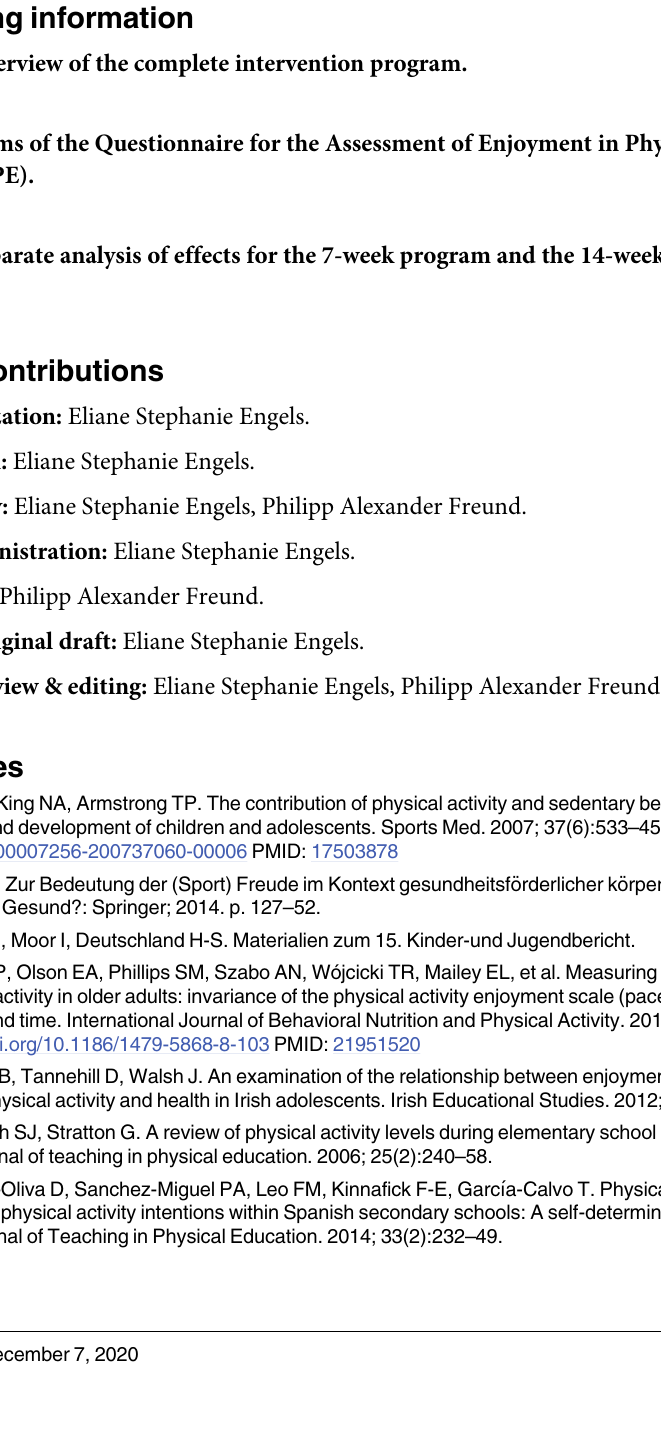
S1 Table. Overview of the complete intervention program. S2 Table. Items of the Questionnaire for the Assessment of Enjoyment in Physical Educa- tion (QUAEPE). S3 Table. Separate analysis of effects for the 7-week program and the 14-week